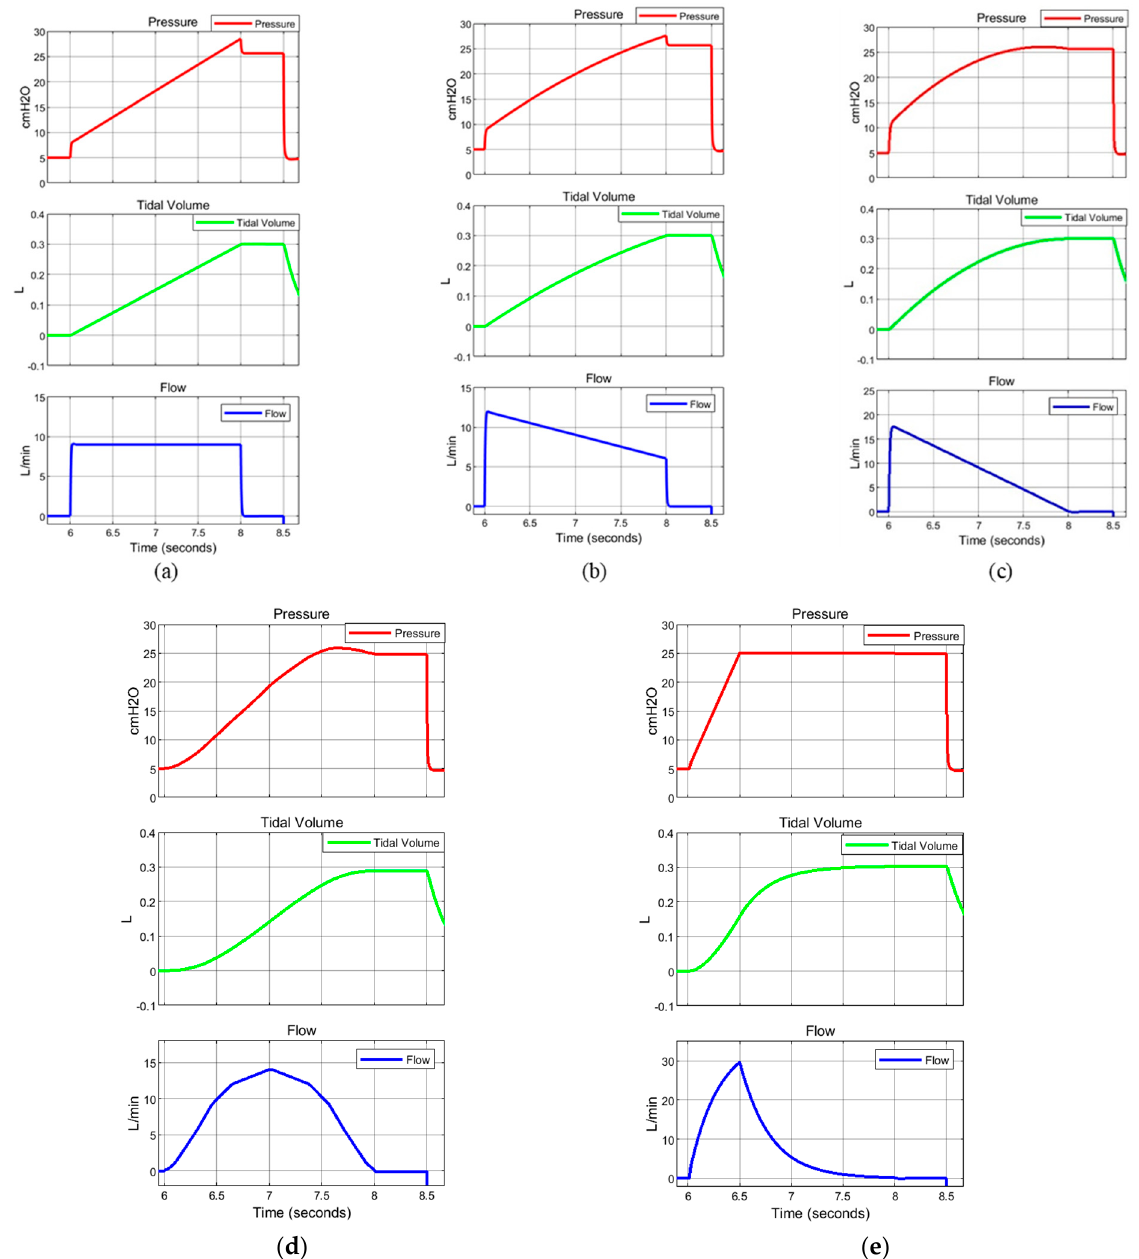
Figure A3. Case 1. Simulation results of VC − CMV and PC − CMV modes in terms of pressure, tidal volume, and inspiratory flow for different inspiratory flow patterns: ( a ) square flow, ( b ) half decelerating, ( c ) full decelerating, ( d ) sinus waveform; and for a inspiratory pressure pattern: ( e ) ramp.